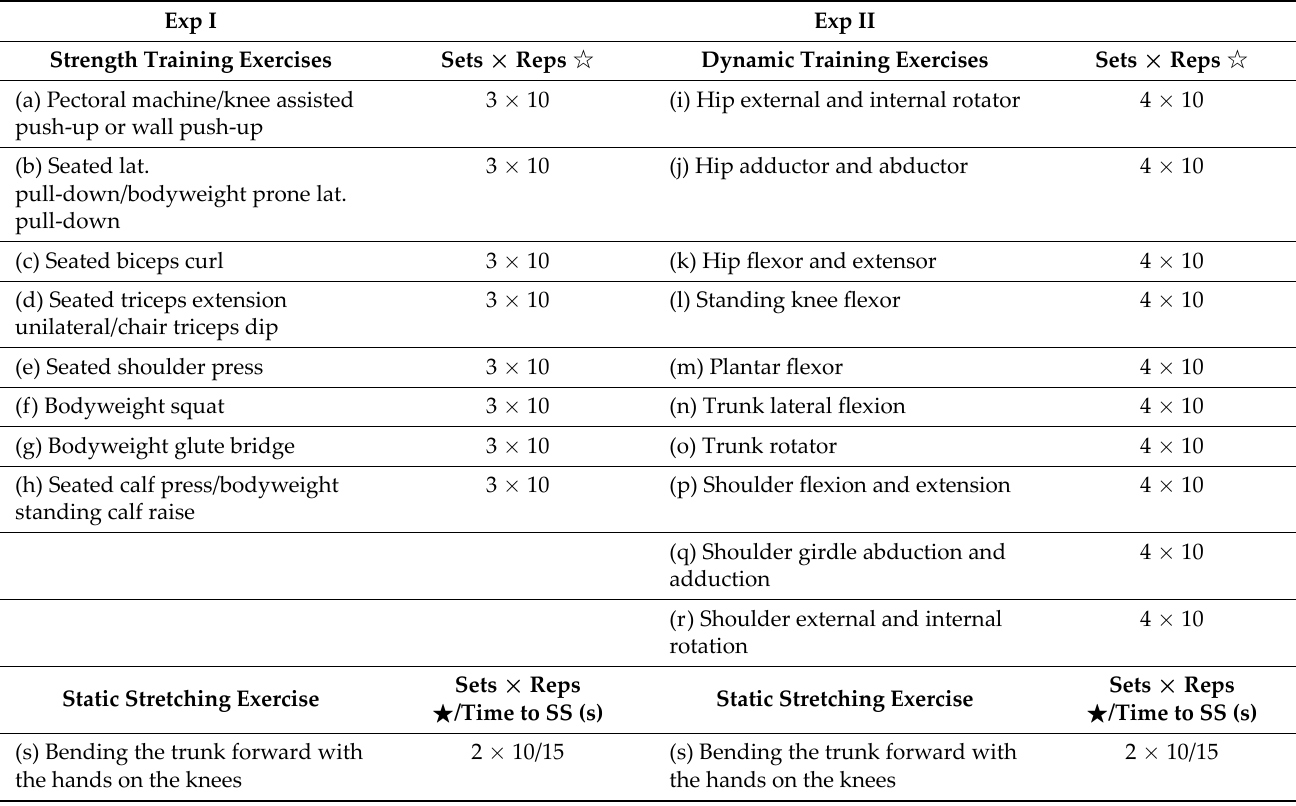
Table 1. Typologies of strength, dynamic and static stretching exercises in the two groups.